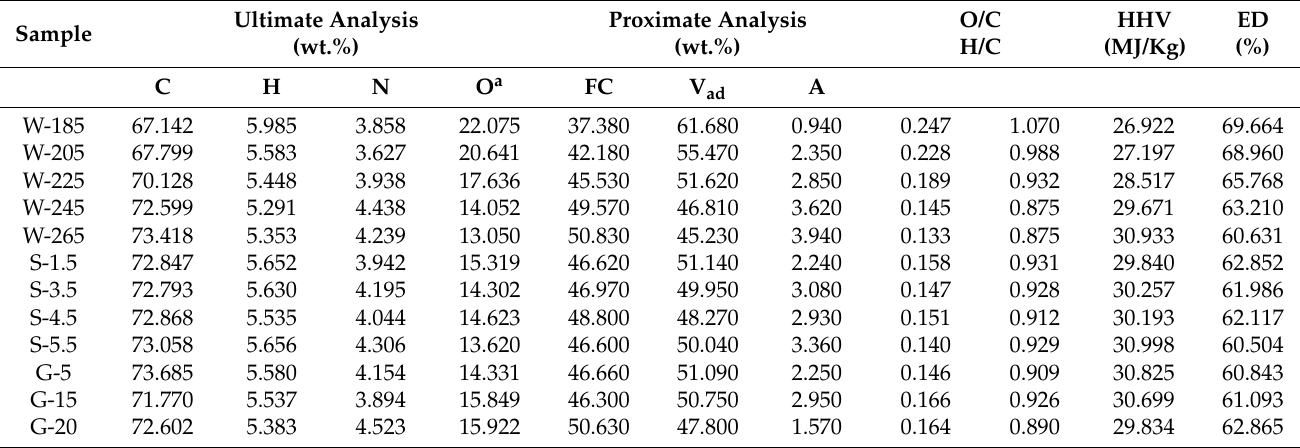
Table 1. Basic characteristic parameters of